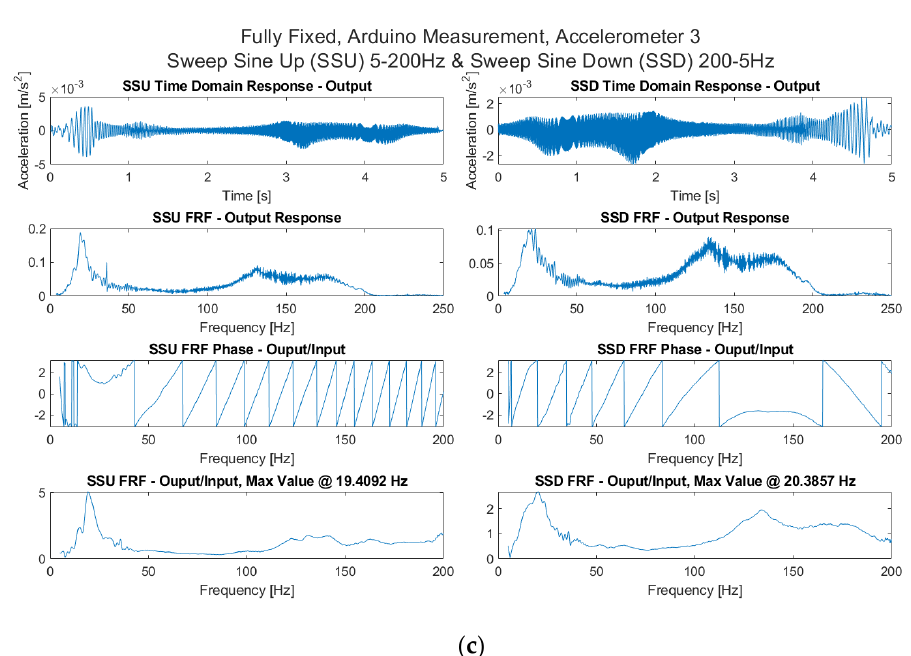
Figure 11. Time and frequency domain responses and FRF estimates from swept sine responses using Arduino measurement for all accelerometers: Fully fixed scenario for ( a ) Accelerometer 1; ( b ) Accelerometer 2 and ( c ) Accelerometer 3.